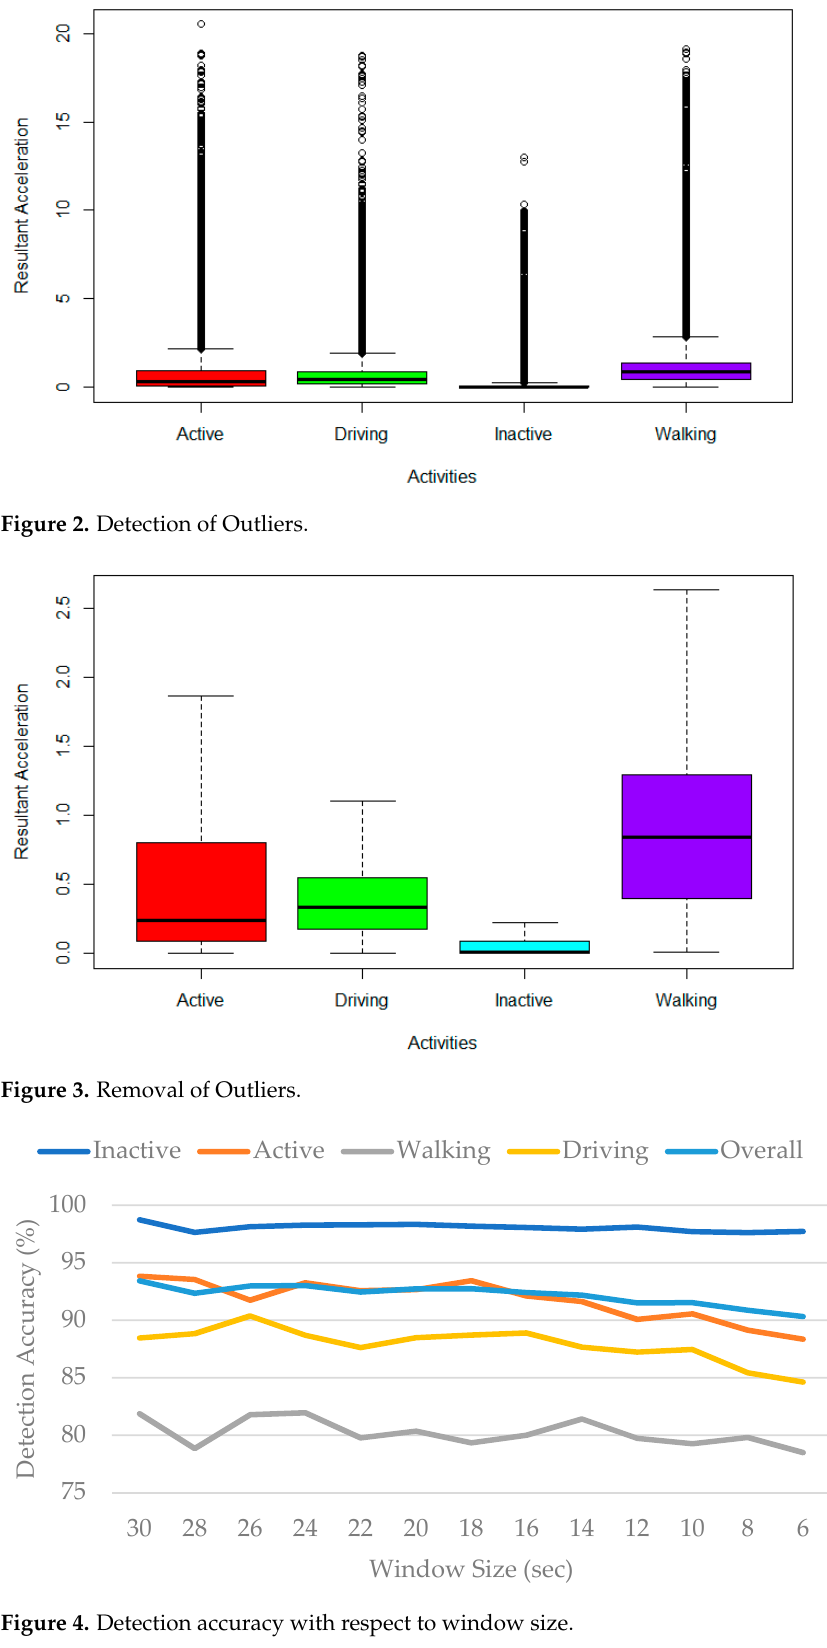
Figure 4. Detection accuracy with respect to window size. Table 1. Detection accuracy with varying overlap values.